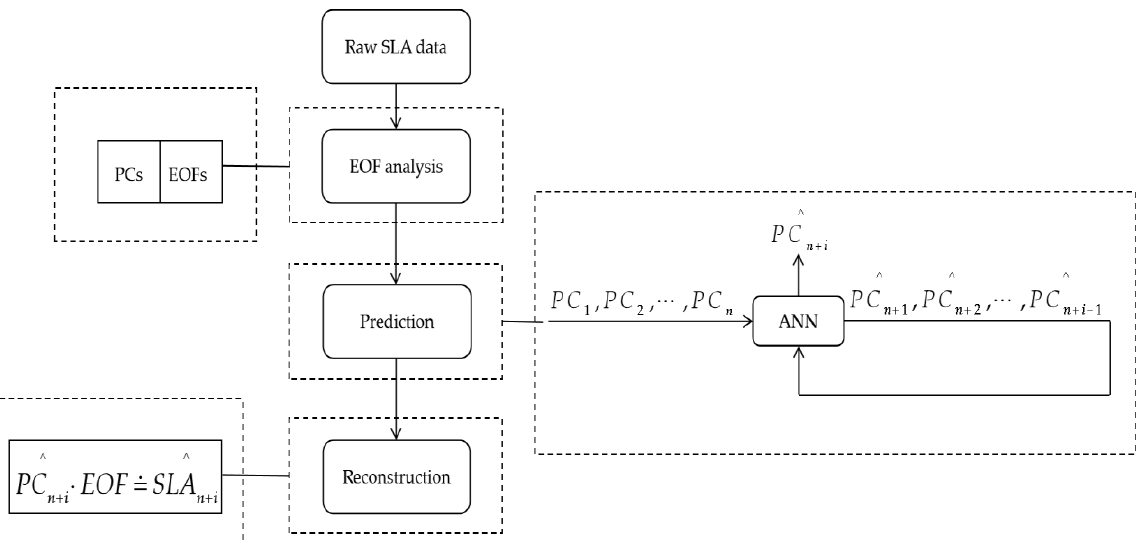
PC rep- i PC represents the predicted PC of the i th time i